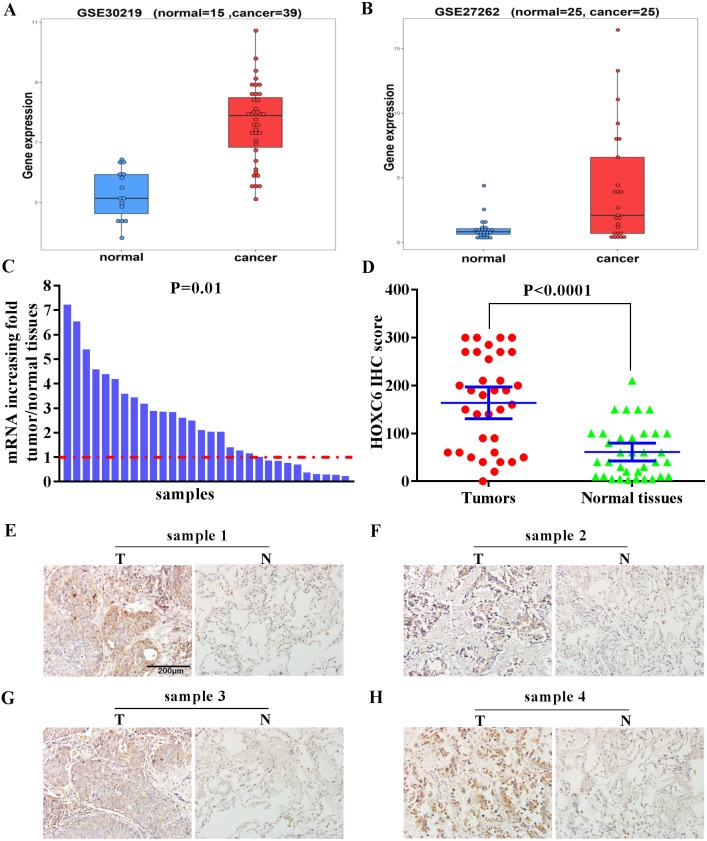
Elevated expression of HOXC6 in NSCLC in comparison to adjacent normal tissues.(A, B) The bioinformatic analysis of publicly available gene expression data sets for HOXC6 expression in lung cancer tissues. Microarray dataset GSE30219 (normal = 15, cancer = 39) and GSE27262 (normal = 25, cancer=25) were download from Gene Expression Omnibus(GEO). HOXC6 expression distribution in (A) and (B), with a fold change of 5 (q. value = 1.4332e–07) and 8.8 (q. value = 0.0039),which were calculated by R package limma ( Ritchie et al., 2015). (C) Relative expression of HOXC6 mRNA in 30 NSCLC and paired adjacent normal tissues as determined by qRT-PCR. The data were assessed using Chi-square test. (D) Expression of HOXC6 protein as determined by IHC. The IHC score of HOXC6 was calculated as the staining intensity (0, 1, 2, or 3) × the staining extent (0–100%). We compared matched samples as in (D) using paired two-tailed Student’s t test. (E) Representative images of IHC staining of HOXC6 in NSCLC tumor (T) and adjacent normal tissues (N), Scale bar = 200 µm.